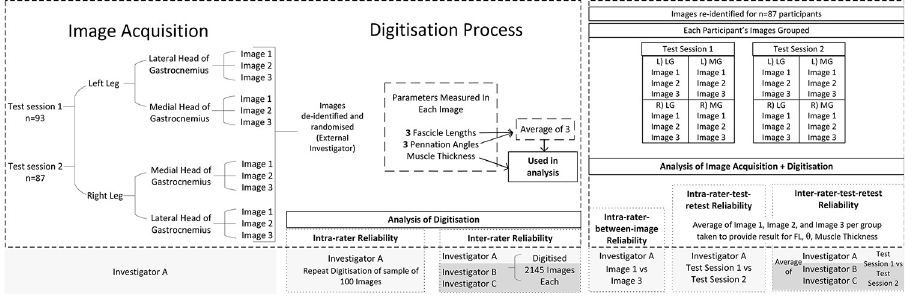
Fig 3. Protocols for reliability